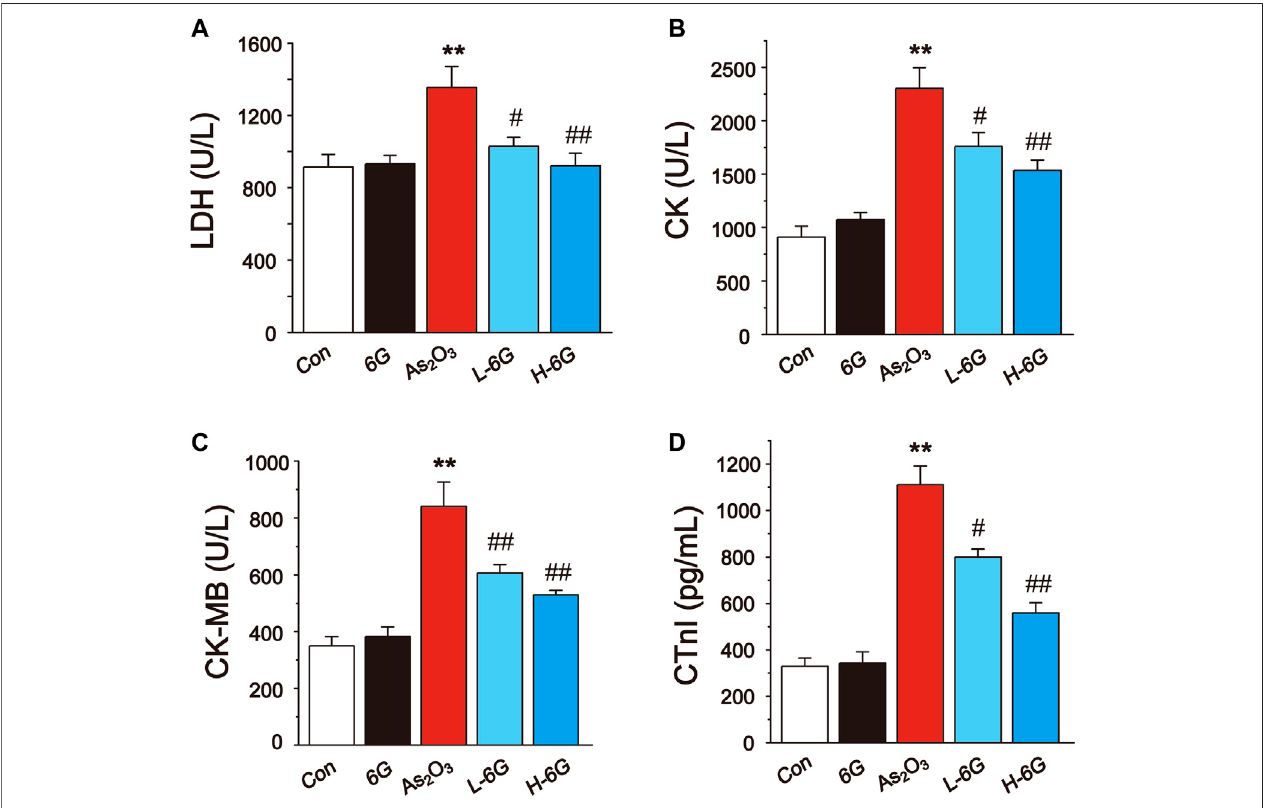
FIGURE 4 | Effect of 6G on the perturbed cardiac injury markers in As 2 O 3 -treated mice. The effects of 6G on serum concentration of LDH (A) , CK (B) , CK-MB (C) and CTnI (D) in each group. Data are expressed as mean ± SEM, n = 6. * p < 0.05, ** p < 0.01 as in comparison to the Con group and # p < 0.05, ## p < 0.01 as in comparison to the As 2 O 3